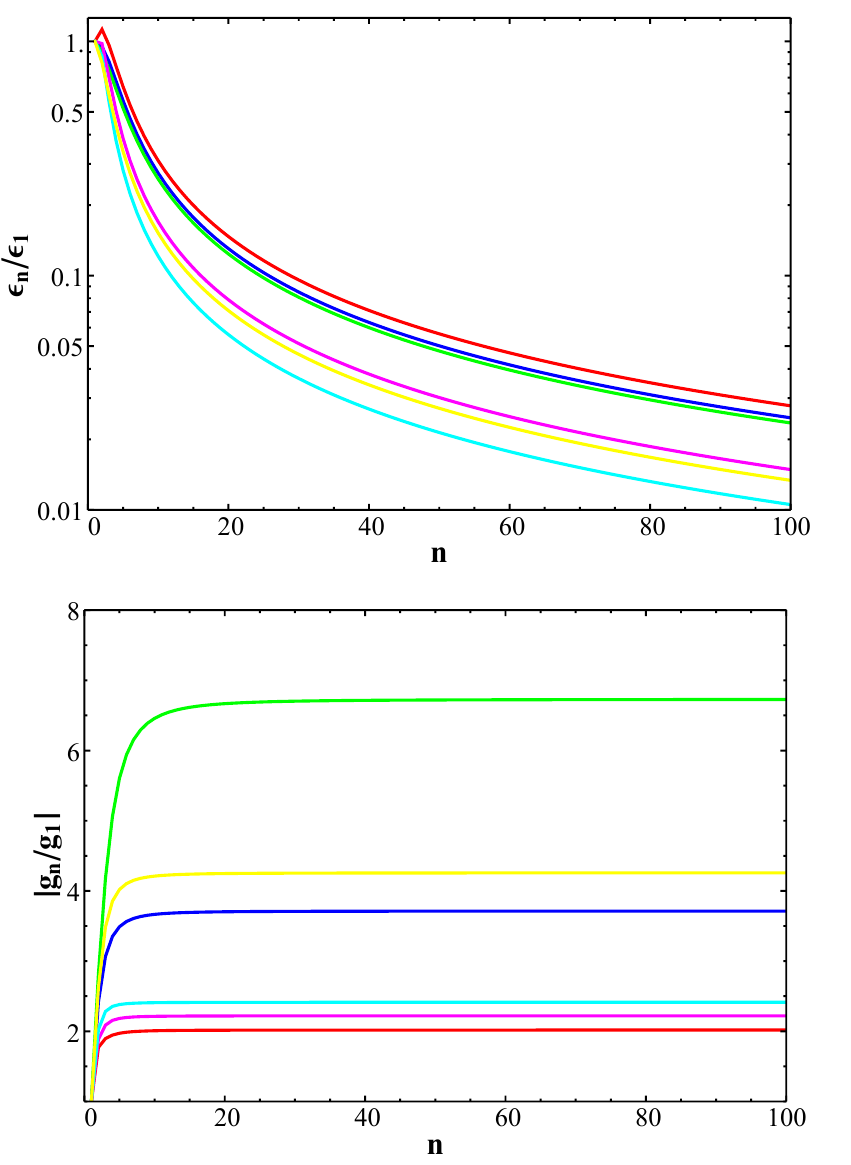
Figure 6 . (Top) The ratio (cid:15) n /(cid:15) 1 as a function of n for various choices of ( τ, a F ) = (1 / 2 , 1 / 2) [red], (1/2,1) [blue], (1/2,3/2) [green], (1,1/2) [magenta], (3/2,1/2) [cyan], and (1,1) [yellow], respectively. (Bottom) Same as the top panel but now for the absolute value of the strength of the n th KK coupling of the dark photon to DM in units of g D . Note that this quantity alternates in